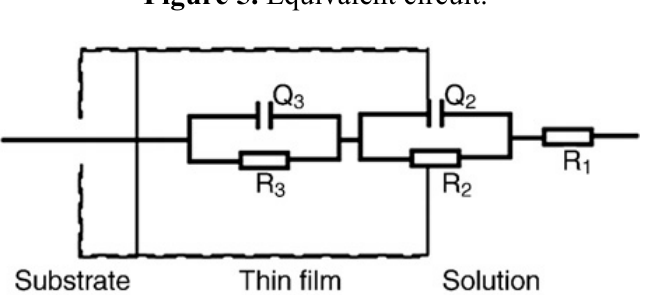
Figure 5. Equivalent